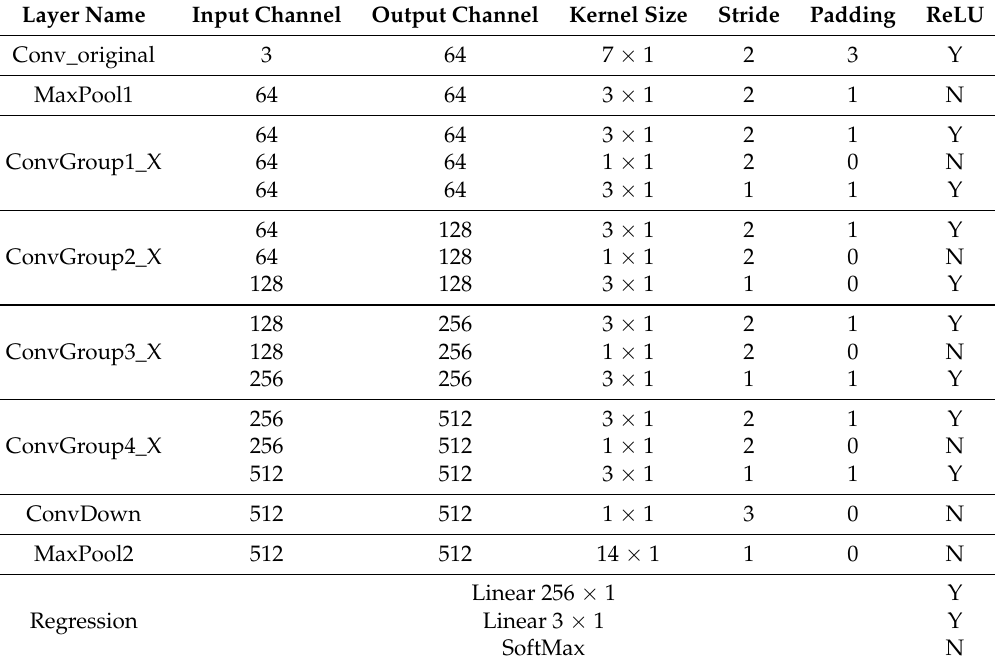
Table 1. The structure of our one-dimensional ResNet. Each convolution layer in this network is followed with a batch normalization operation.